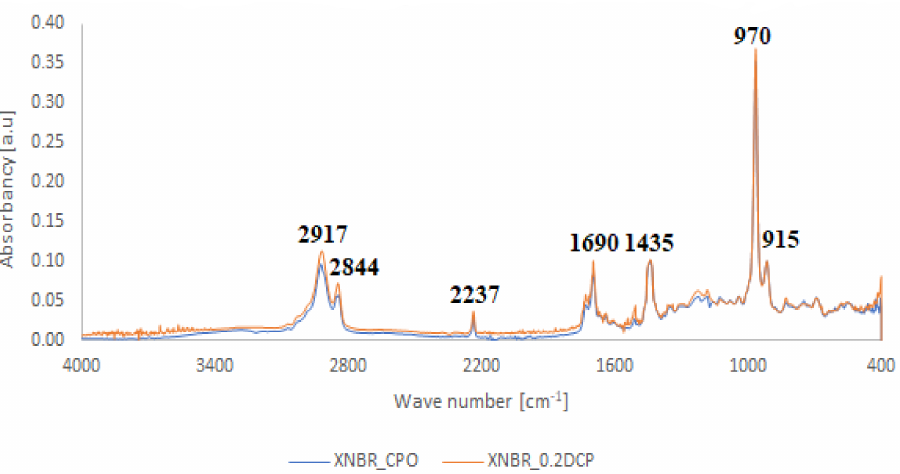
Figure 5. Comparison between FTIR spectra illustrating the way of crosslinking of XNBR with CPO oligomer (XNBR_2CPO) and DCP